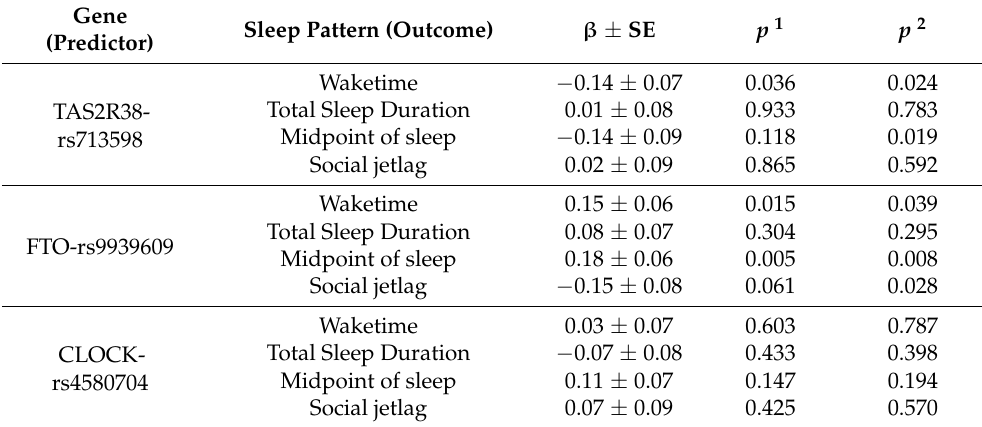
Table 7. Associations between selected polymorphisms and sleep